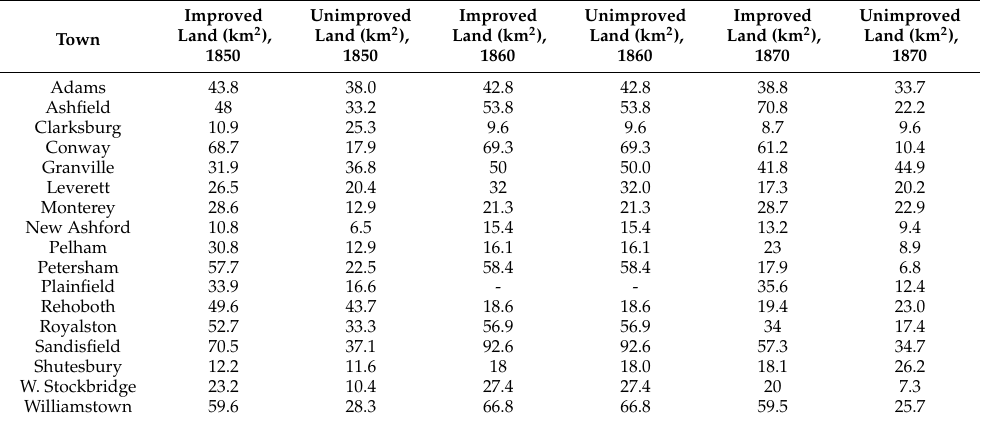
Table A1. Improved and unimproved land for 1850, 1860, and 1870 from the U.S. Census Nonpopu- lation Schedule for Agriculture.